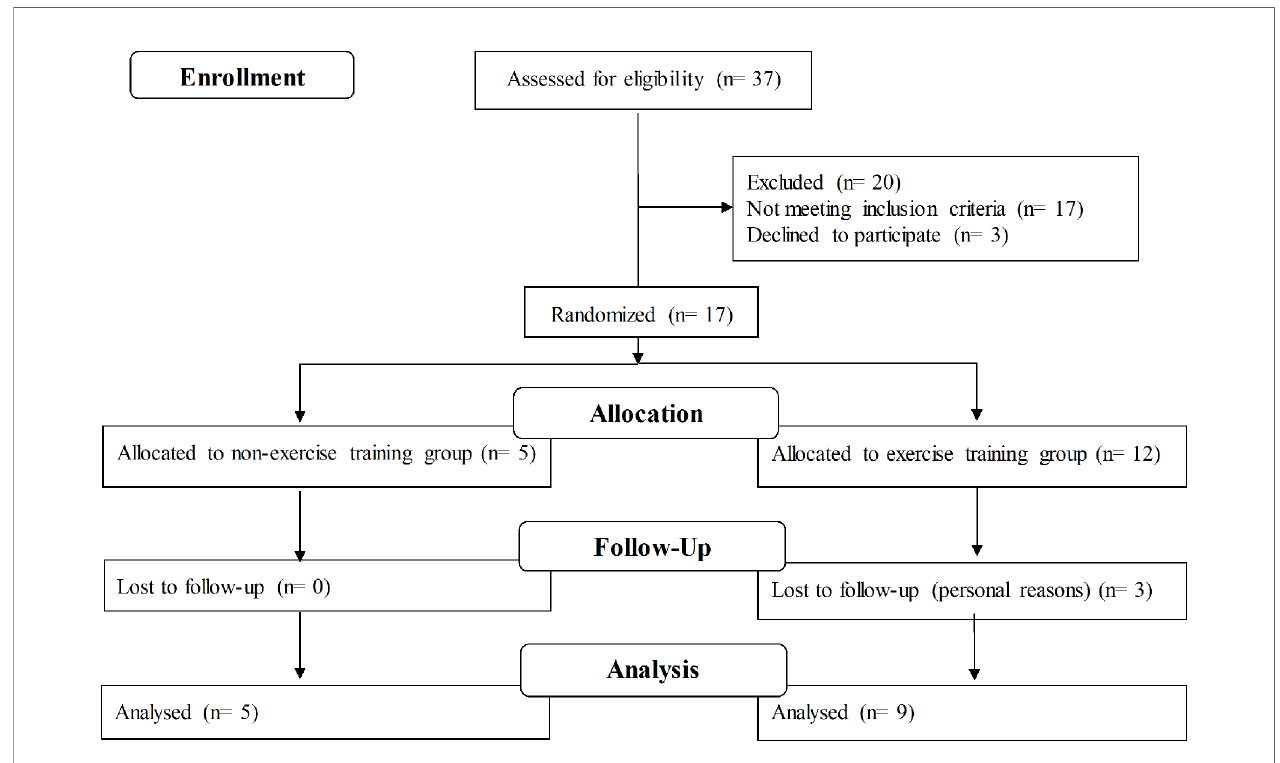
FIGURE 1 | Flow diagram.